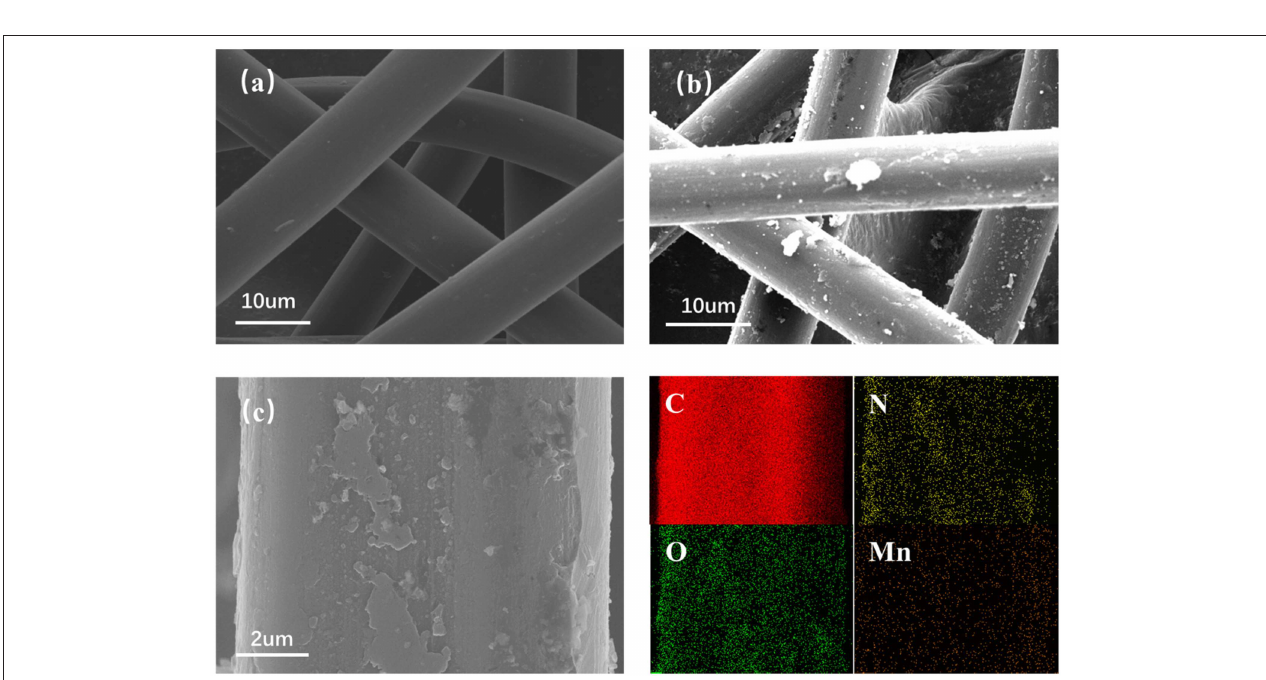
FIGURE 2 | The scanning electron microscopy (SEM) images of (a) CF, (b) COP BTC -Mn/CF. (c) EDS spectra of C, N, O, and Mn elements in the COP BTC -Mn/CF. Corresponding elemental mapping images for (red) C, (yellow) N, (green) O, and (orange) Mn, respectively.